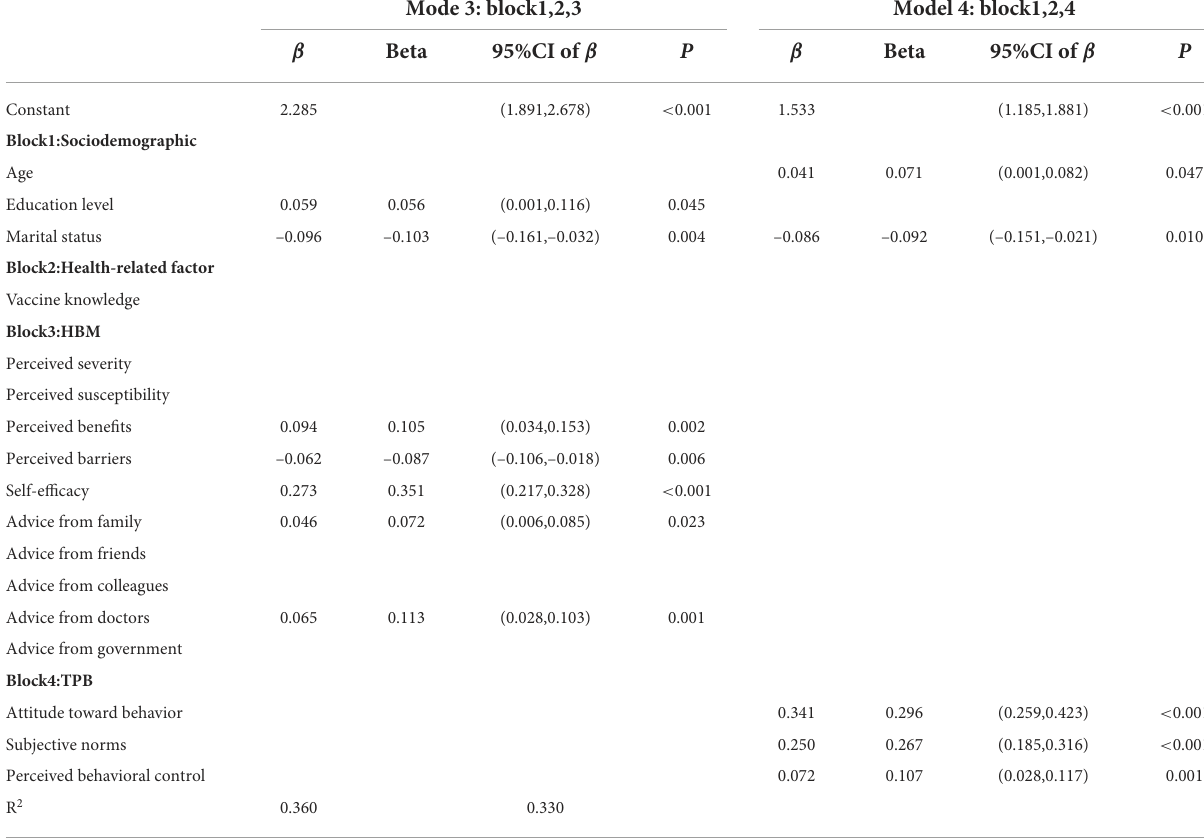
TABLE 4 Multiple linear regression analysis–predictors of intention to get future vaccinated against COVID-19 (the vaccine non-hesitant